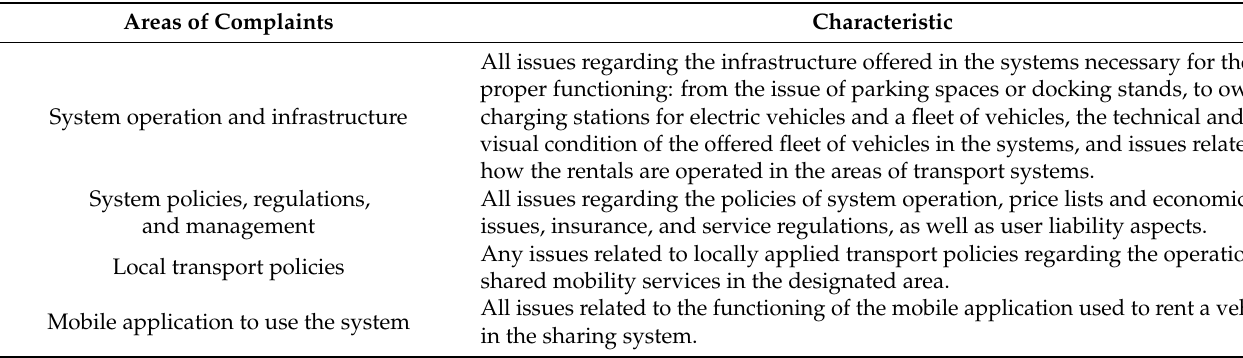
Table 3. Areas of complaints about shared mobility